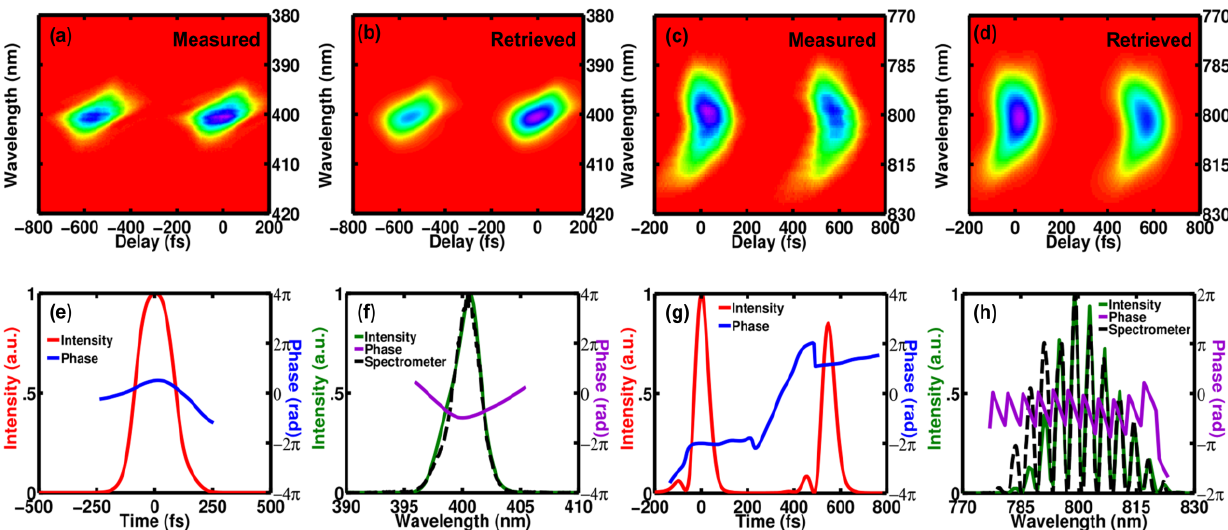
Figure 13. The measured DB PG FROG traces for ( a ) a simple pulse at 400nm and ( c ) a well separated double pulse at 800nm. The retrieved traces ( b ) and ( d ) with a FROG error of 0.83% and 0.52% for (a) and (c), respectively. ( e ) and ( g ), retrieved pulse intensity and phase in temporal domain. ( f ) and ( h ), the measured spectrum and the spectral phase compared with a measurement made by a spectrometer